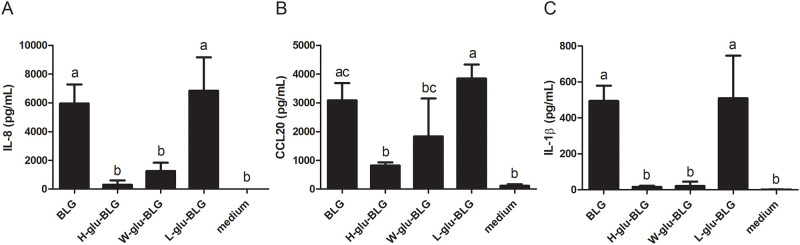
Cytokine and chemokine responses of macrophages upon exposure to native or heat-treated BLG varies.BLG was untreated or heated (W, H or L) in the presence of glucose and the soluble fraction was incubated with macrophages. The cytokine secretion of IL-8 (A), CCL20 (B) and IL-1β (C) was analysed in the supernatant with ELISA. The results represent mean values ± SD of 2–4 independent experimental measurements. The statistical differences were calculated with Tukey’s Test with different letters (a–c) in the bars indicated significantly different (p < 0.05).